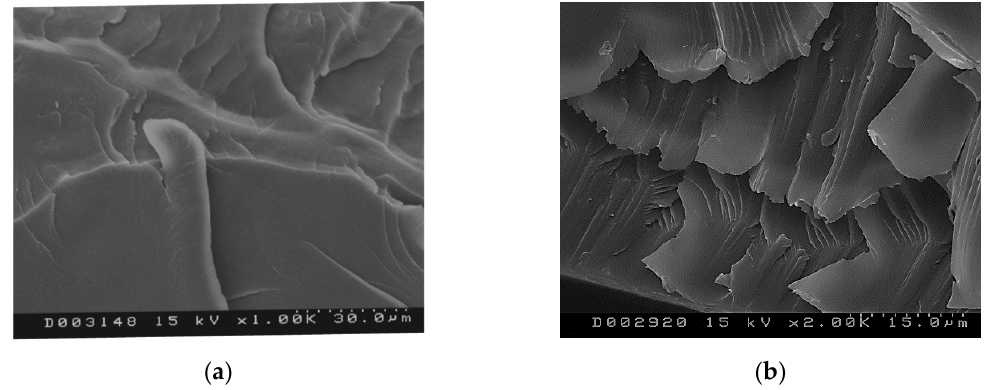
Figure 9. SEM image of the sample 5050DDM. ( a ) ×1.00 k magnification and ( b ) ×2.00 k magnification).